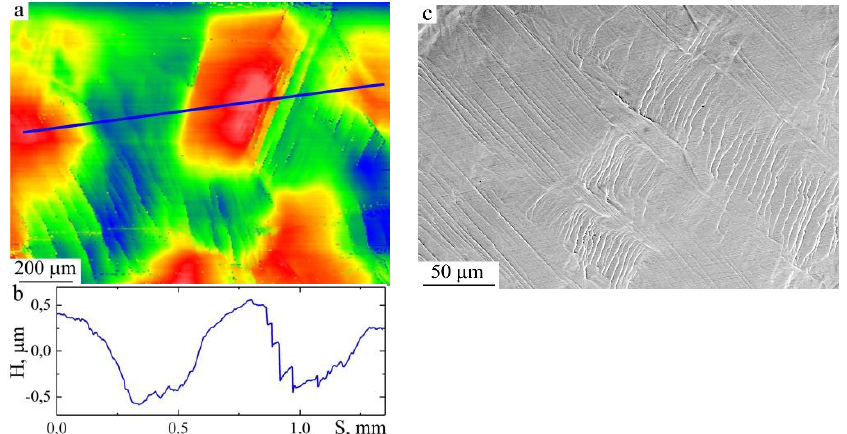
Fig. 5. Images of the surface (a, c) and corresponding profile (c) of EBF 3 Ti–6Al–4V samples subjected to uniaxial tension for  = 8 %. Optical profilometry (a, b) and scanning electron mycroscopy (c).